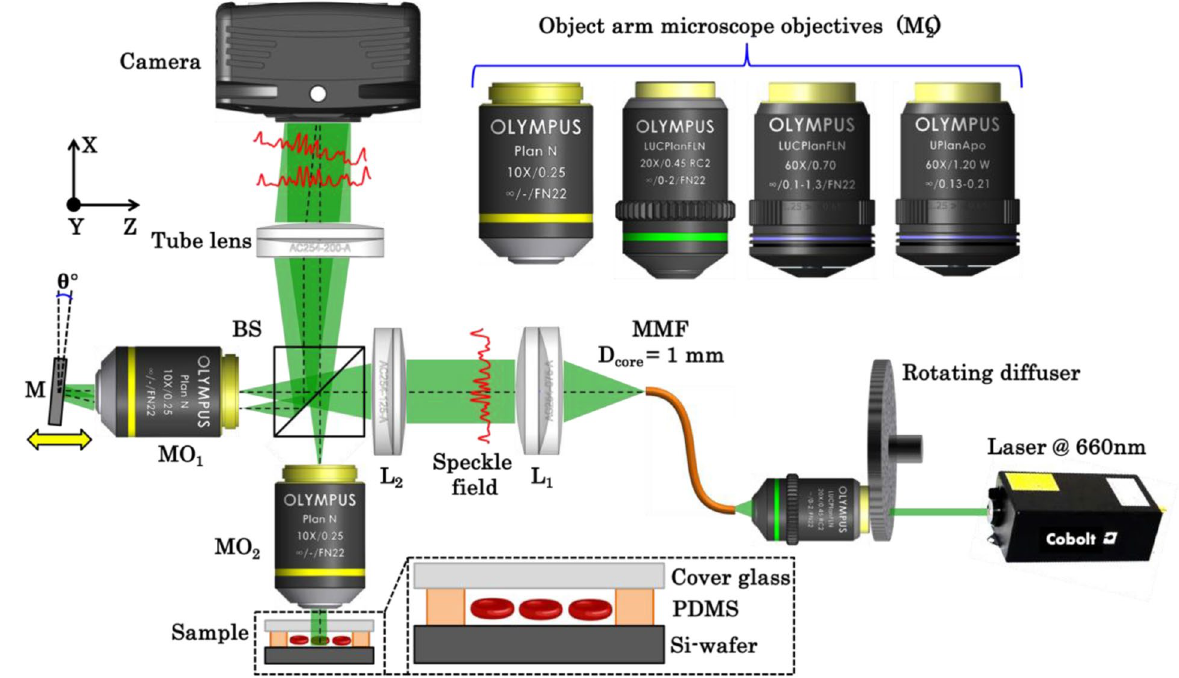
Figure 8. Schematic diagram of the DSI based IM system. MO 1–2 microscope objectives, BS beam splitters, L 1–2 lenses, MMF multi-mode fiber, M mirror and CMOS complementary metal oxide semiconductor